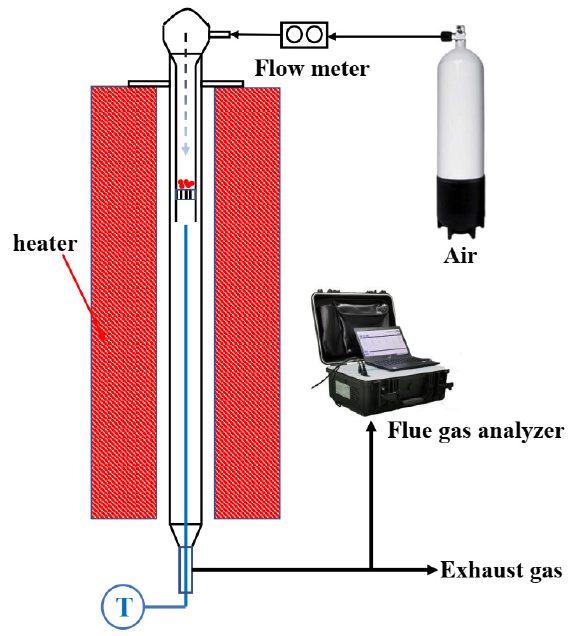
Figure 1. Schematic diagram of the fixed bed combustor.